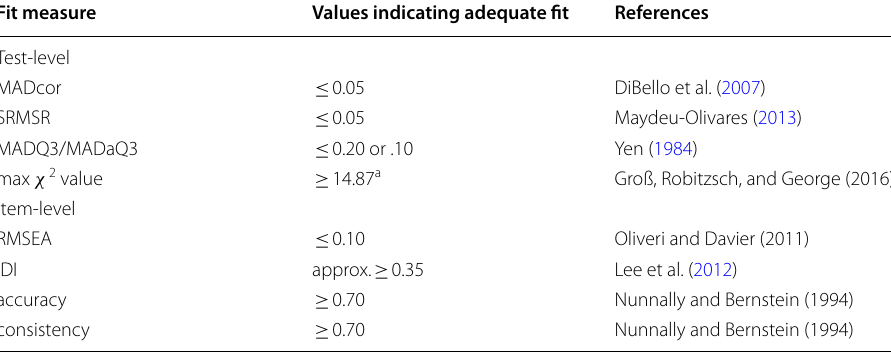
Table 2 Central test-level and item-level fit indices used in CDM research